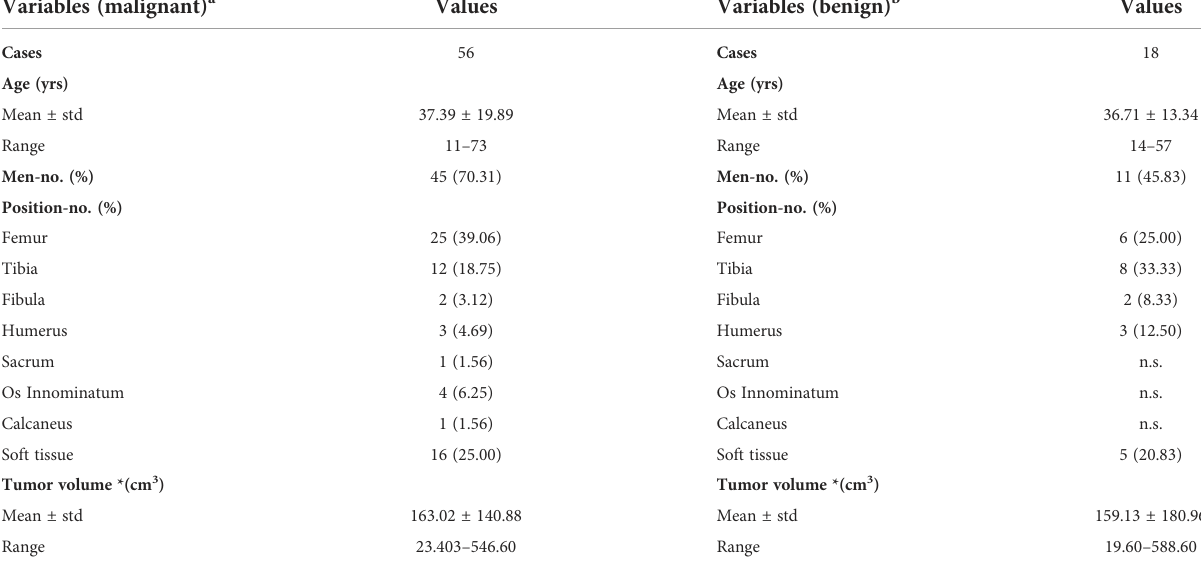
TABLE 1 Demographic and tumor information of 74 cases with malignant or benign musculoskeletal tumors. Variables (malignant) a Values Variables (benign) b